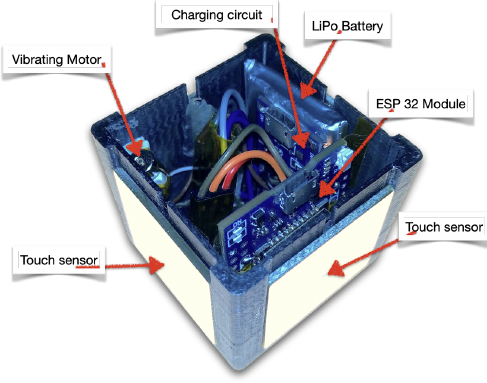
Figure 3. Internal view of the